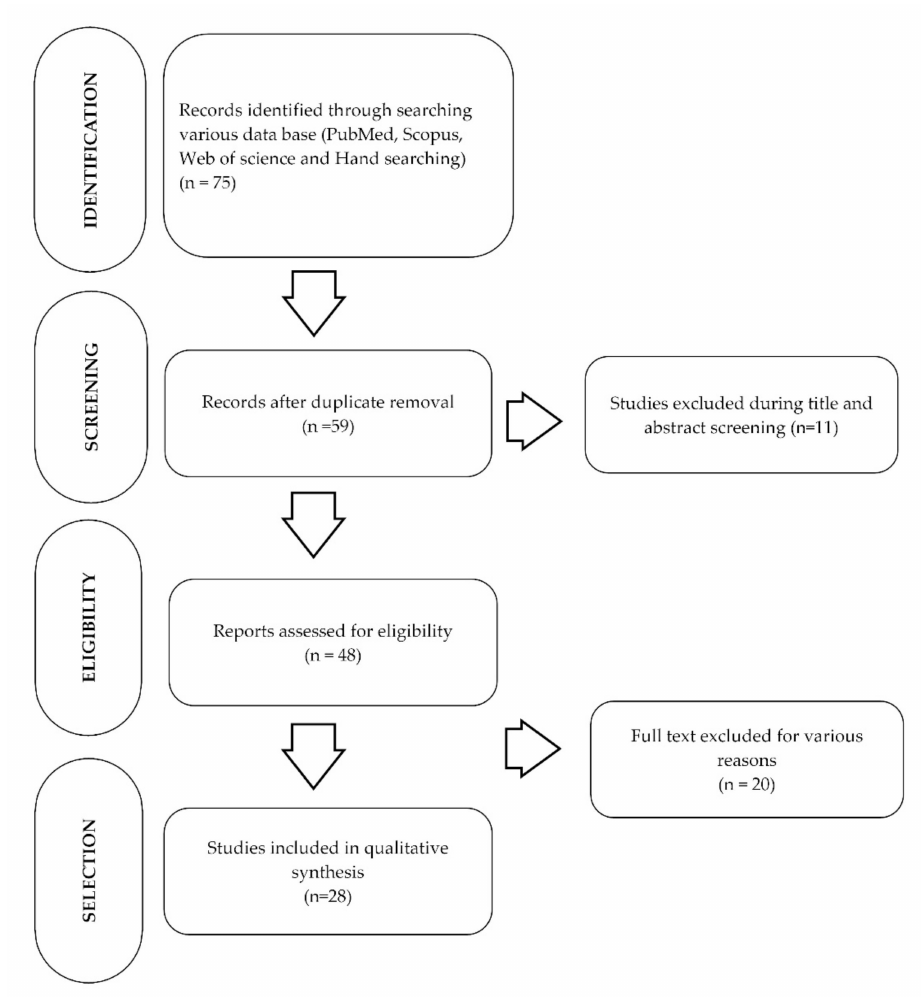
Figure 1. PRISMA flow diagram showing the selection of articles included in the